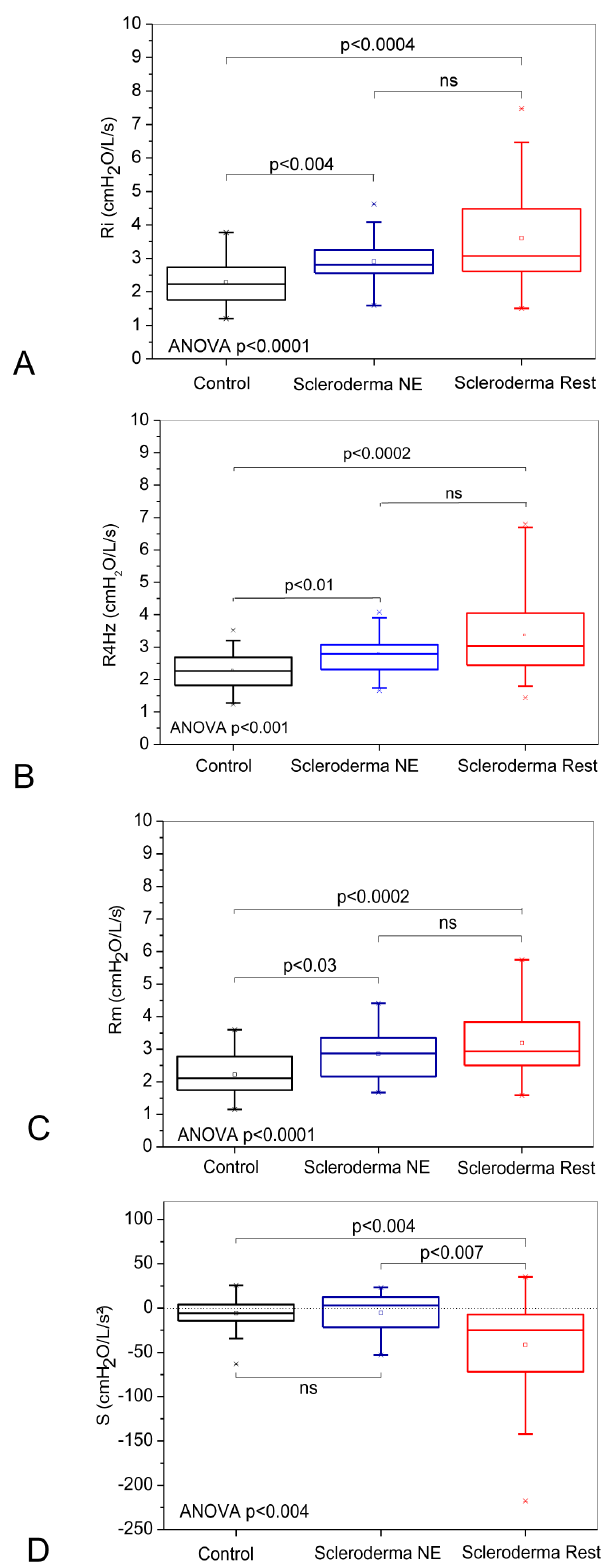
Figure 2. Comparison of the resistive parameters obtained from groups of patients classified according to the spirometric exams. Analyses using the forced oscillations technique showed that the total resistance of the respiratory system (Ri; Figure A) and